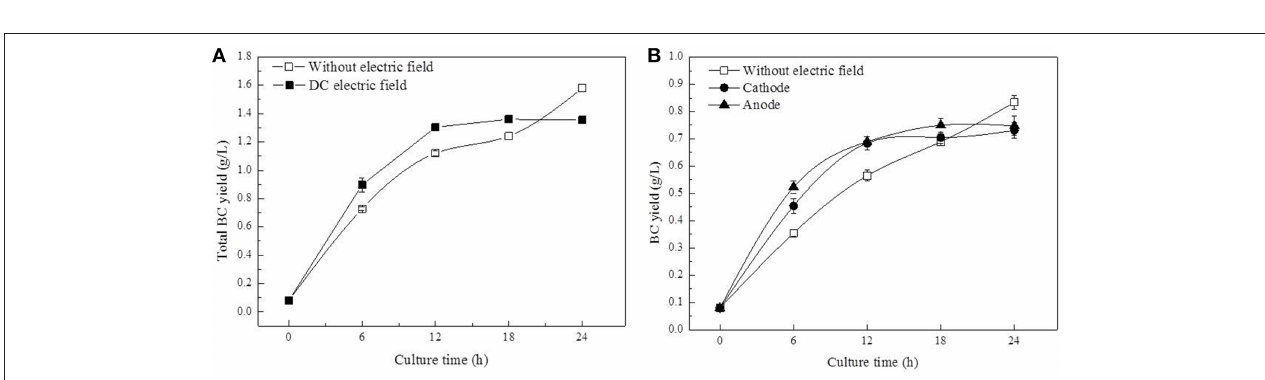
FIGURE 3 | BC yield of G. xylinus cultured with/without DC electric field. ( A , Total yield of anode and cathode; B , Anode/Cathode yield).